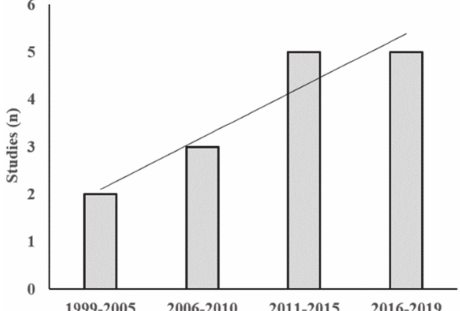
Figure 1. Date of publication of the selected